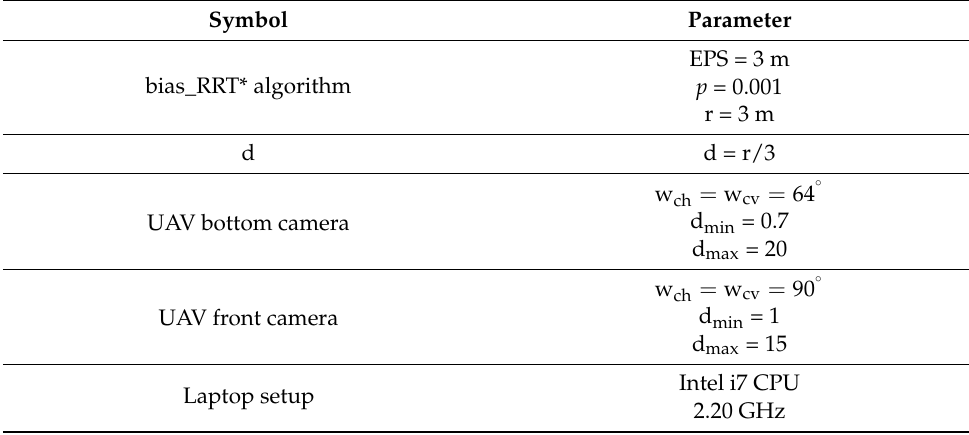
Table 1. Simulation experiment parameters.